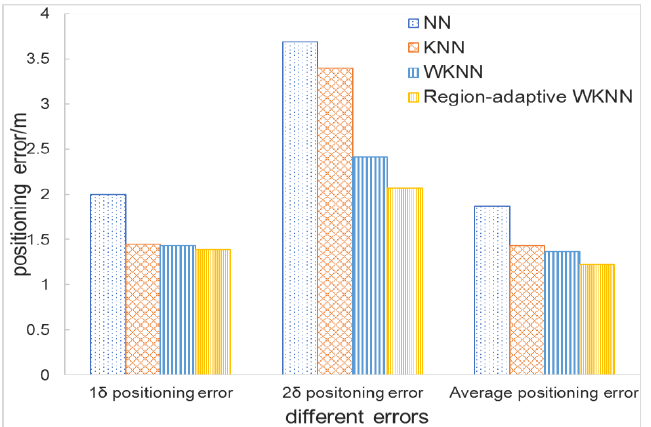
Figure 16. Comparison of average positioning error of different positioning algorithms before and after calibration.